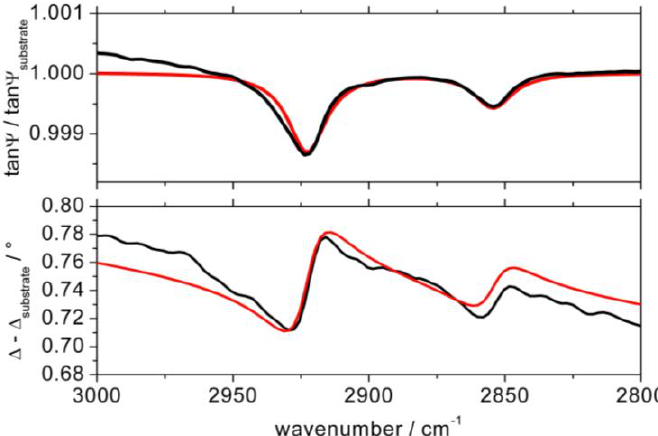
Figure 3. Simulated (red line) and experimental (black line) fragment of the ellipsometric tanψ spectrum (top) and Δ spectrum (bottom) of 5a . The following quantities were used for the calculations: n = 1.4, d = 2.85 nm. Adopting the total ∞ oscillator strength parameters as used in Reference 31 the respective oscillator strength components F and F were determined: F = 40,500 cm −2 and F = 4,000 cm −2 for x z x z ν (CH ) at 2,851 cm −1 and F = 66,250 cm −2 and F = 9,000 cm −2 for ν (CH ) at s 2 x z as 2 2,919 cm −1 . A value of 17 cm −1 was used for full width at half maximum FWHM (Γ ) of i both bands. Subsequent substitution of these quantities in Equations 2 and 3 yields the dielectric function and the correlated optical